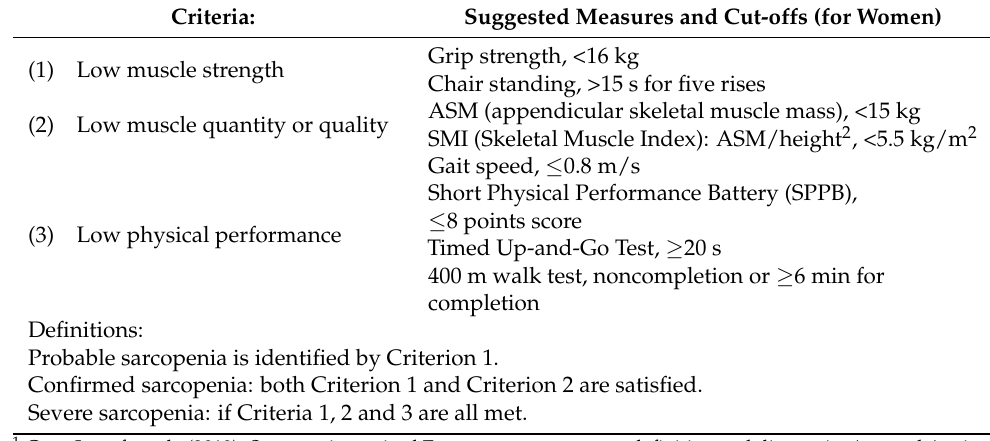
Table 1. Definition of sarcopenia by European Working Group on Sarcopenia in Older People (EWGSOP2) guidelines 1